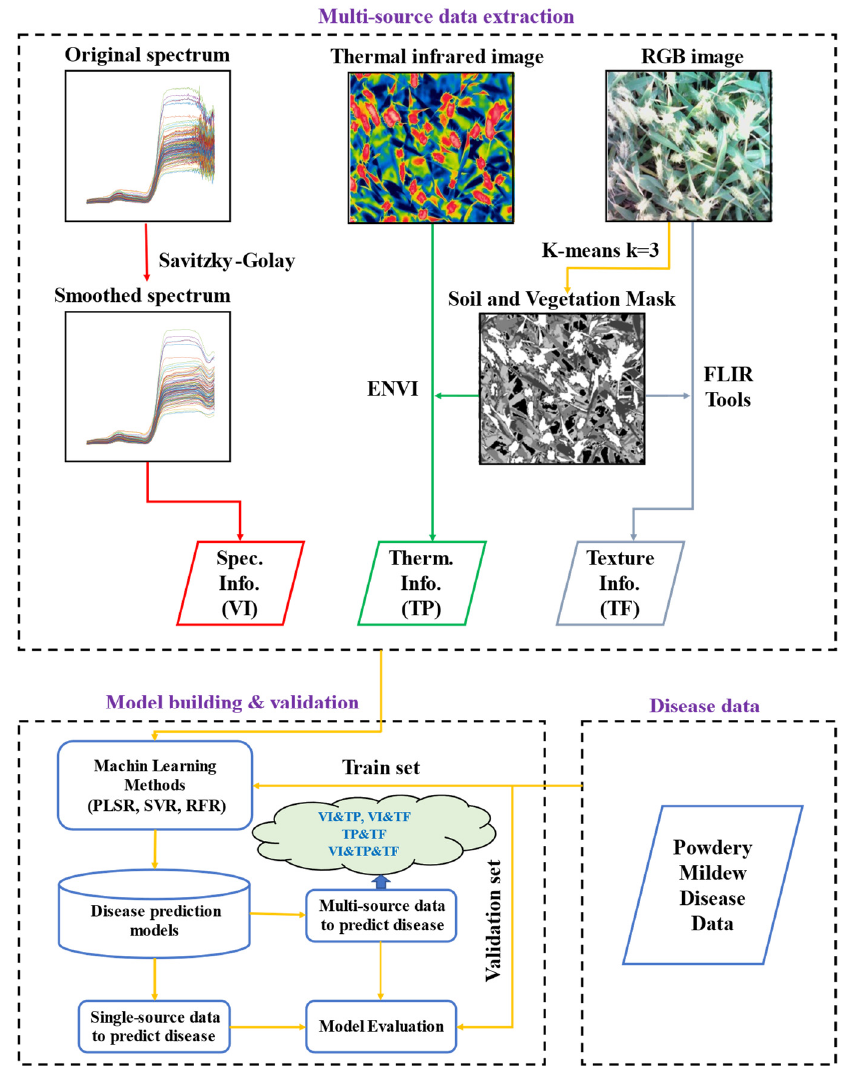
Figure 3. A workflow diagram of feature extraction and modeling.